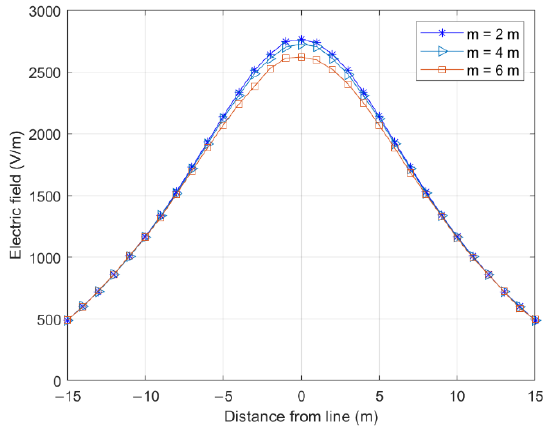
Figure 15. Effect of height difference on cross-level electric field.